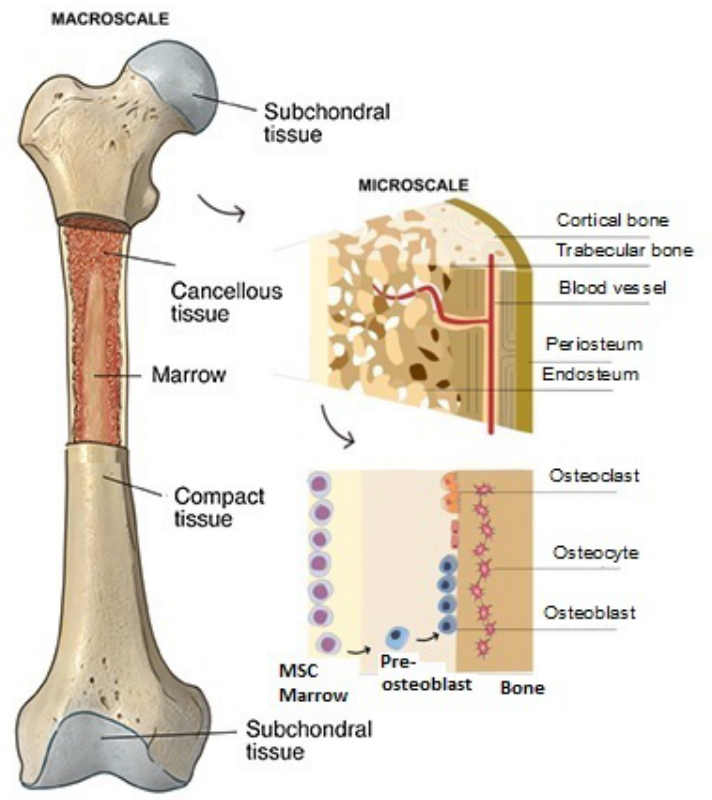
Figure 1. The macroscale and microscale (mesenchymal stem cells (MSCs)) of femur bone tissue [6]. Due to their shape and capacity to bond to the bone matrix (an example of the mech- anism of bone cell proliferation within a geopolymer scaffold is reported in Figure 2), amorphous silicate-based materials have drawn much attention in the scientific study of the regeneration of hard tissues. Geopolymers have recently been studied as prosthetic biomaterials, and there are few academic papers on their use in BTE [7–10].